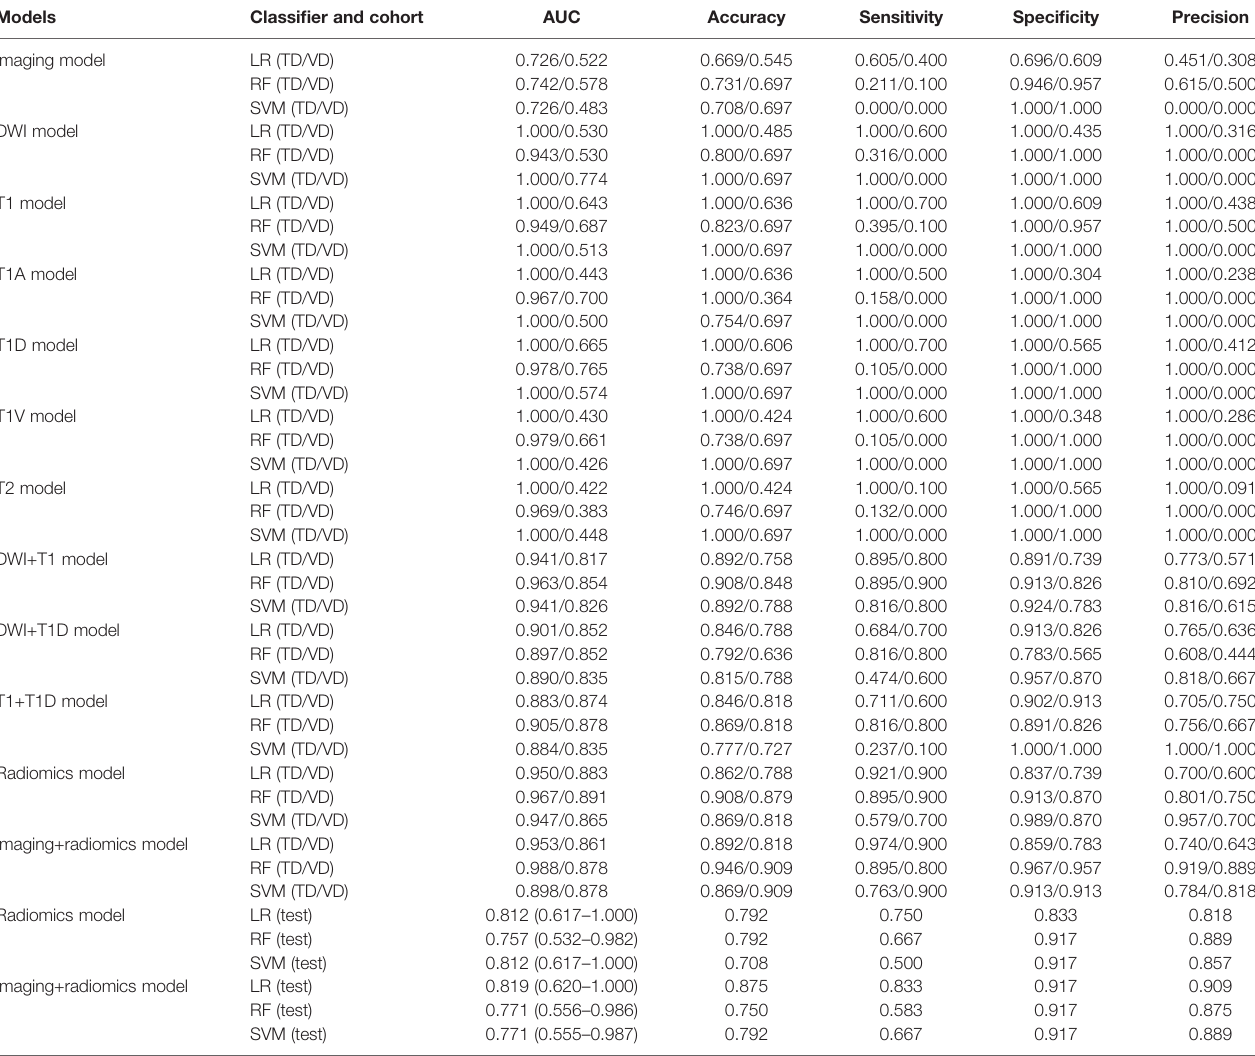
TABLE 3 | The performance of imaging, radiomics of single and multiple MR sequences, and fi nal fusion models for predicting MVI in ICC patients.